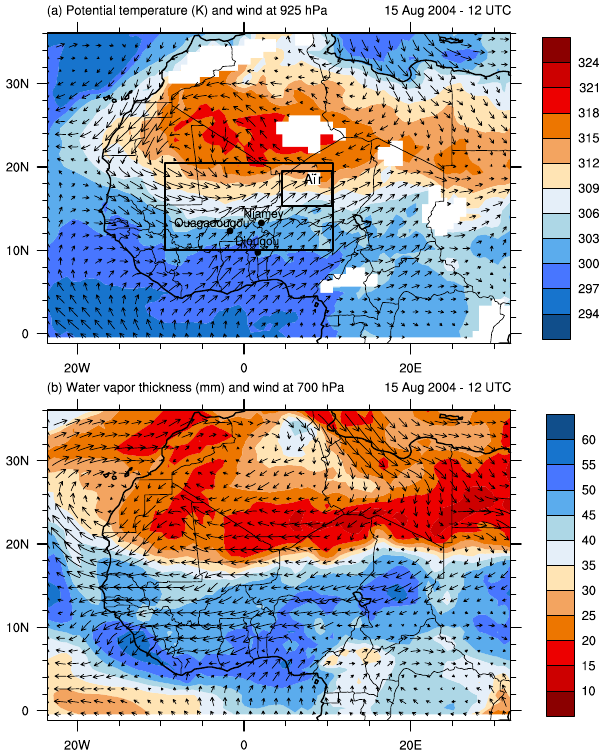
Fig. 1. Large-scale fields at 12:00UTC 15 August 2004: (a) po- tential temperature (K) and wind vectors at 925hPa and (b) water vapor thickness (mm) and wind vectors at 700hPa. The rectangles indicate the position of the two inner